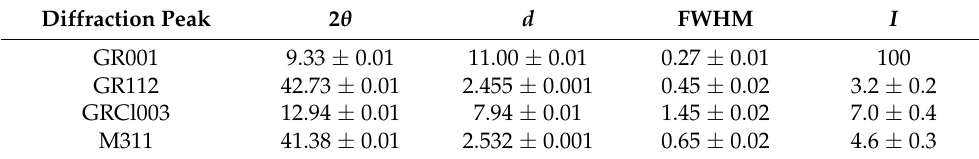
Table 3. Abiotic precipitate aged for 1 week: characteristics of the diffraction peaks GR001 and GR112 of GR(SO 42 − ), GRCl003 of GR(Cl − ) and M311 of magnetite; 2 θ = diffraction angle, in degree, d = interplanar distance (Å), FWHM = full width a half maximum, in degree, and I = peak intensity, with I = 100 for GR001.